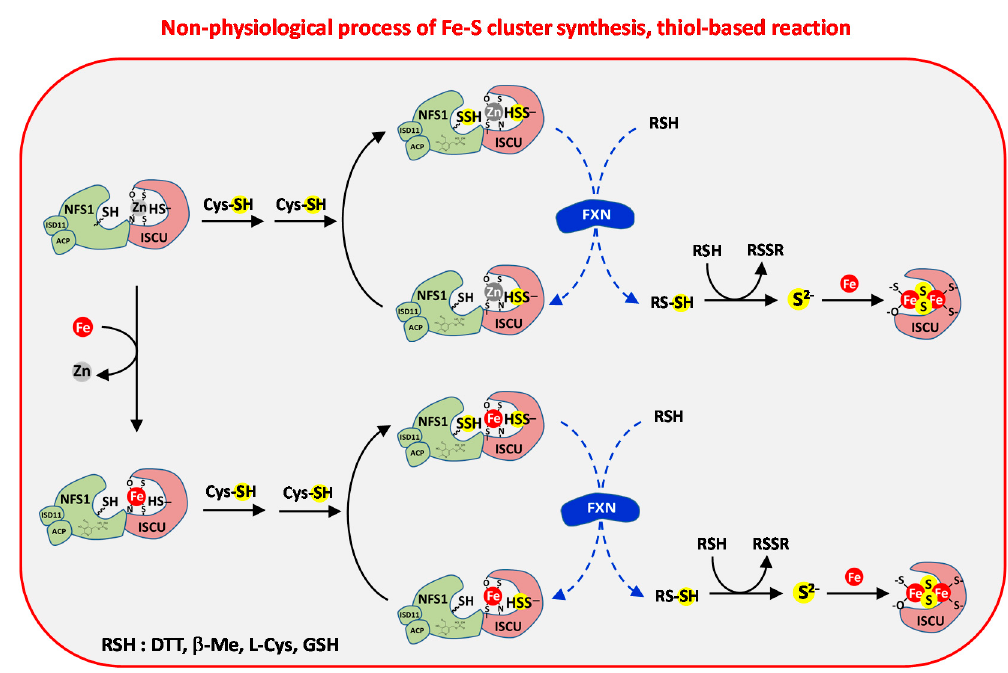
Figure 11. Thiol-based Fe–S cluster synthesis by the eukaryotic ISC machinery. The thiol-based reaction is described for the zinc- and iron-loaded ISCU. In both cases, the reaction is initiated by formation of an NFS1–ISD11–ACP–ISCU complex persulfidated on both NFS1 and ISCU, then thiols, (RSH) such as L -cysteine, DTT, GSH or β -mercaptoethanol, reduce the persulfide of NFS1, which leads to sulfide release. In the presence of iron, the sulfide ions generate Fe–S clusters in ISCU via a poorly defined mechanism. The dashed blue arrows refer to the rate-limiting steps that are accelerated by FXN.